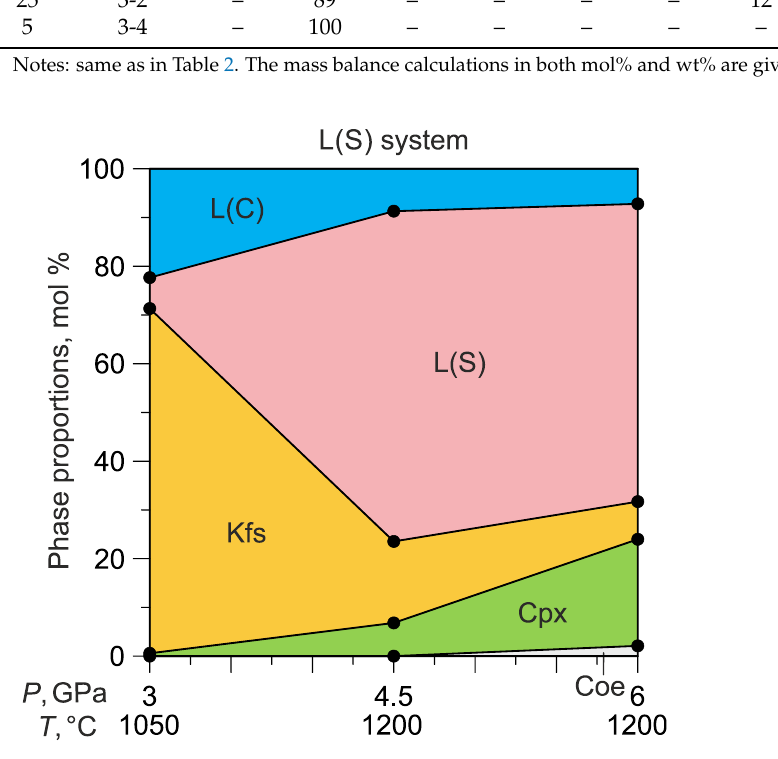
Figure 7. Calculated modes in mole fractions (Table 3) of the phases in the system L(S) as a function of pressure.